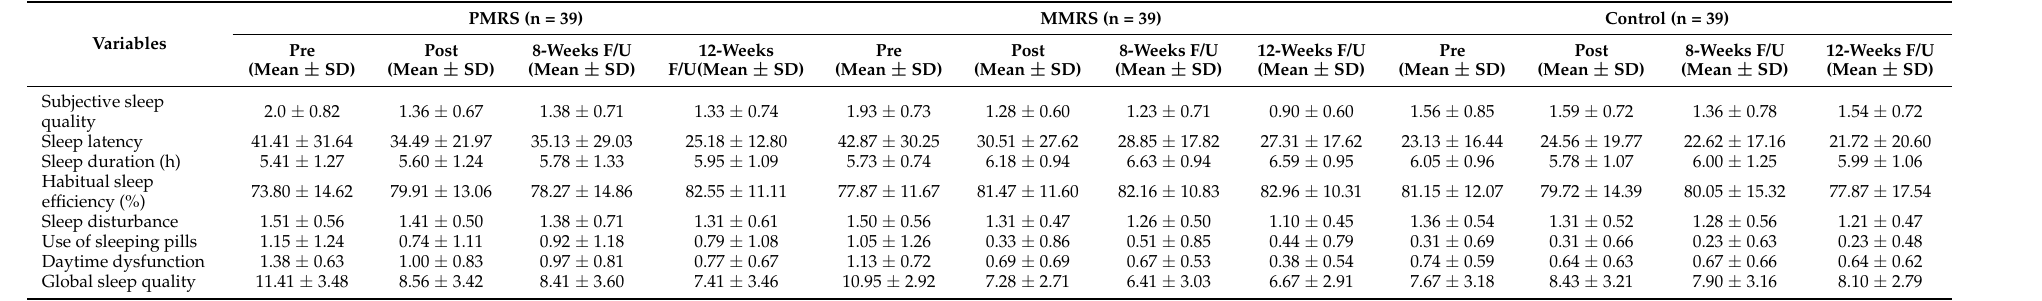
Table 3. Distribution of subjective sleep parameters